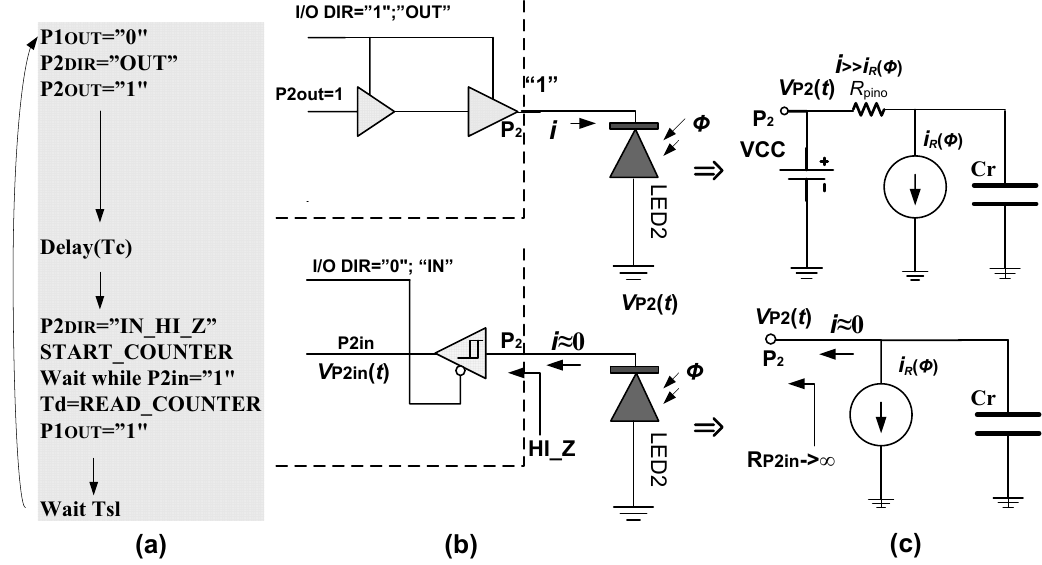
Figure 2. ( a ) Algorithmic steps. ( b ) LED’s biasing process. ( c ) Equivalent